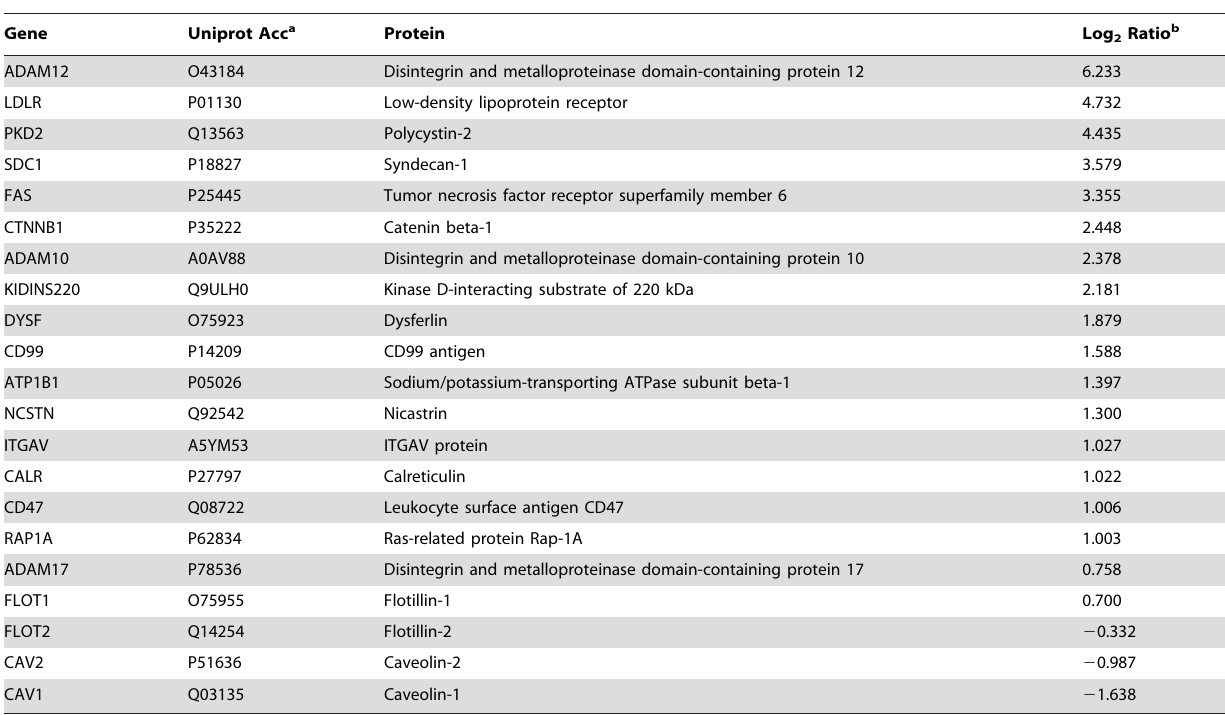
Table 1. An abbreviated list of TGF- b 1-induced lipid raft-associated proteins in hASCs.